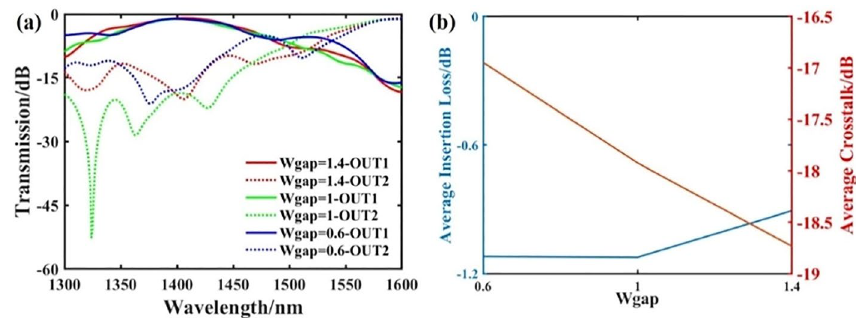
Figure 2. The effect of output waveguide spacing change on device performance. ( a ) The transmittance spectrum of the wavelength demultiplexer under different output waveguide spacing conditions. ( b ) The average insertion loss and crosstalk of the two target channels under different output waveguide spacing conditions.